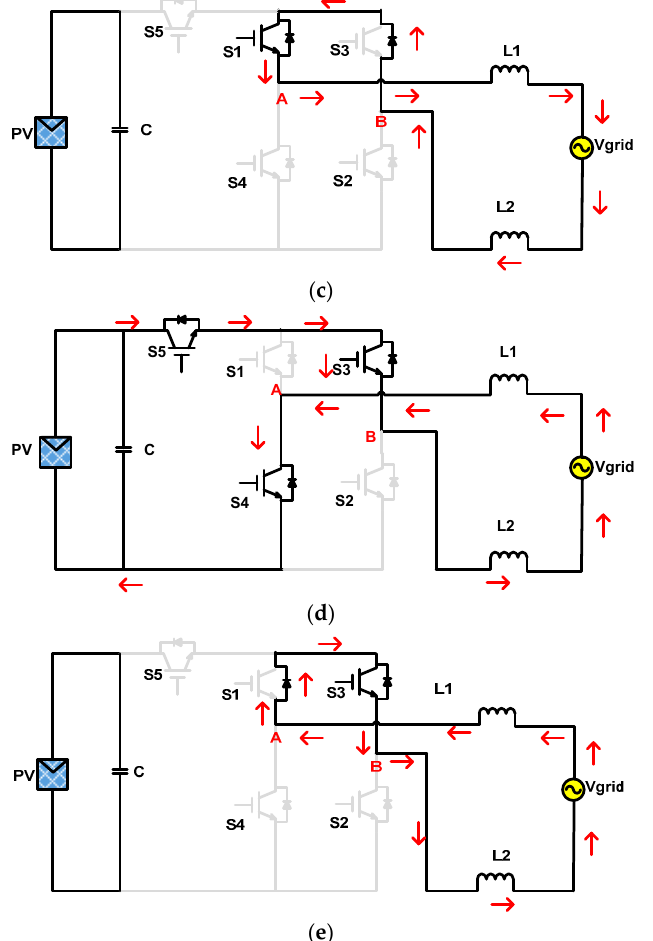
Figure 6 . H5 inverter and its operating modes. ( a ) H5 inverter circuit, ( b ) current conduction during the positive half cycle of the grid voltage, ( c ) freewheeling mode during the positive half cycle of the grid voltage, ( d ) current conduction during the negative half cycle of the grid voltage and ( e ) freewheeling mode during the negative half cycle of the grid voltage.